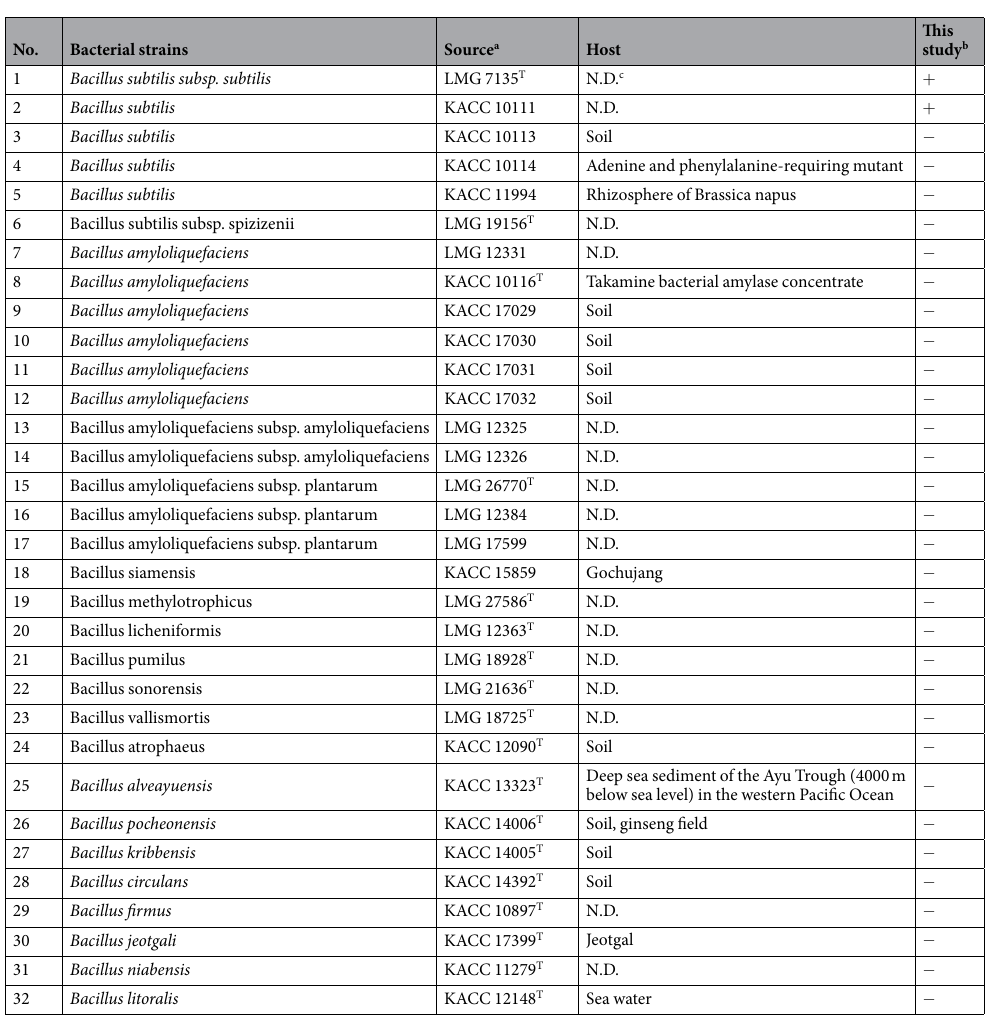
Table 3. Bacterial strains used in the PCR specificity test for Bacillus subtilis subsp. subtilis . a Superscript “T” indicates type strain. b Conventional or real-time assay; + and – indicate species detected or not detected, respectively. c N.D., Not